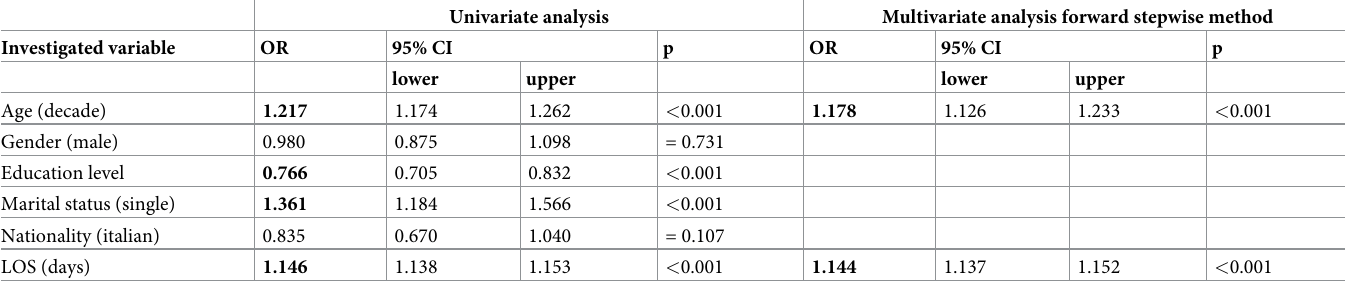
Table 2. Association between sociodemographic and outcome variables for infections with HAI associated microorganisms: a binary logistic regression analysis.